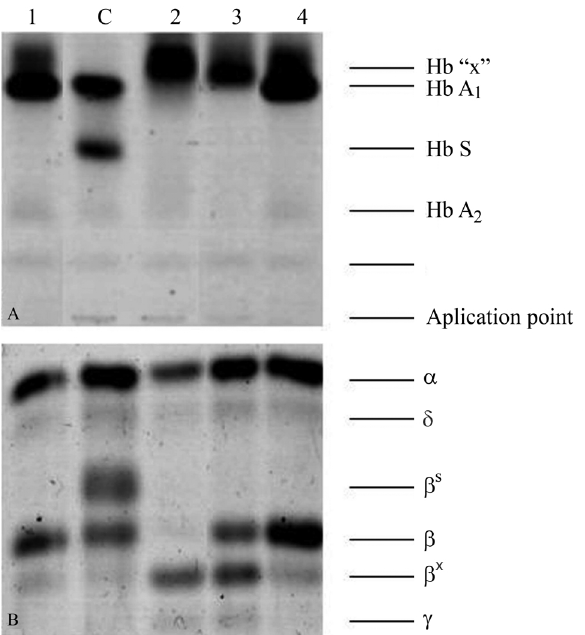
Figure 1 - Electrophoresis: (A) Alkaline electrophoresis: faster HbA mi- gration in the propositus and his father. (B) Globin chain electrophoresis: slower (cid:1) -chain migration ( (cid:1) x ) in the propositus and his father. Lanes: (1) mother; (2) propositus; (3) father; (4) normal brother; (C) control, hetero- zygous for sickle cell